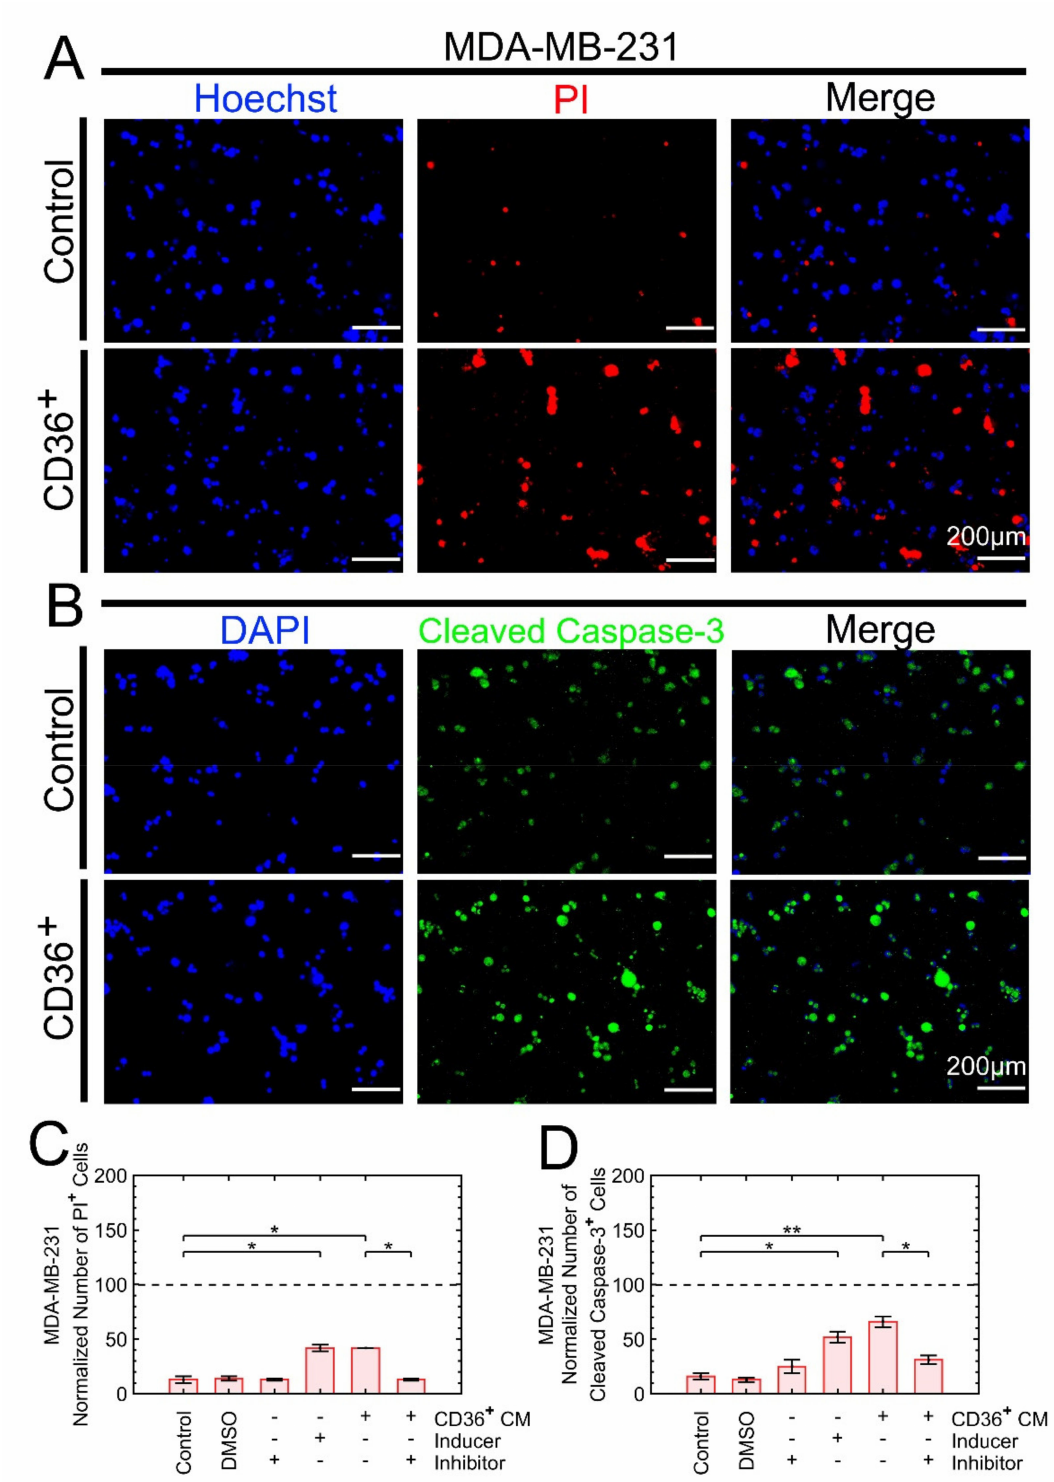
Figure 3. Exposure to the CM of CD36 + FBs increases the frequency of apoptotic cells. ( A , C ) PI staining indicated a higher frequency of cell death with exposure to the CM of CD36 + FBs. ( B ) Cleaved caspase-3 staining was monitored with fluorescent microscopy. ( C , D ) Inducer and inhibitor of apoptosis pathway enabled the selection of a threshold for quantitative analysis. In both cases, the frequencies of apoptotic cells, as the result of exposure to the CM of CD36 + FB, were the same as the treatment with apoptosis inducer. * p < 0.05, ** p <